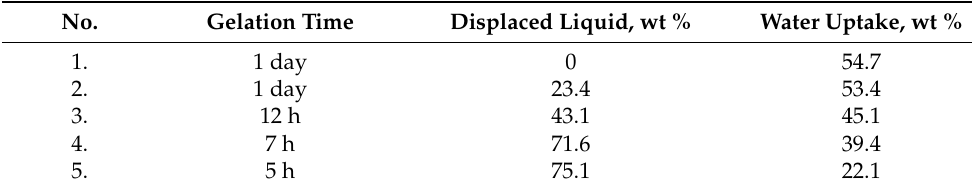
Table 3. Parameters of synthesized